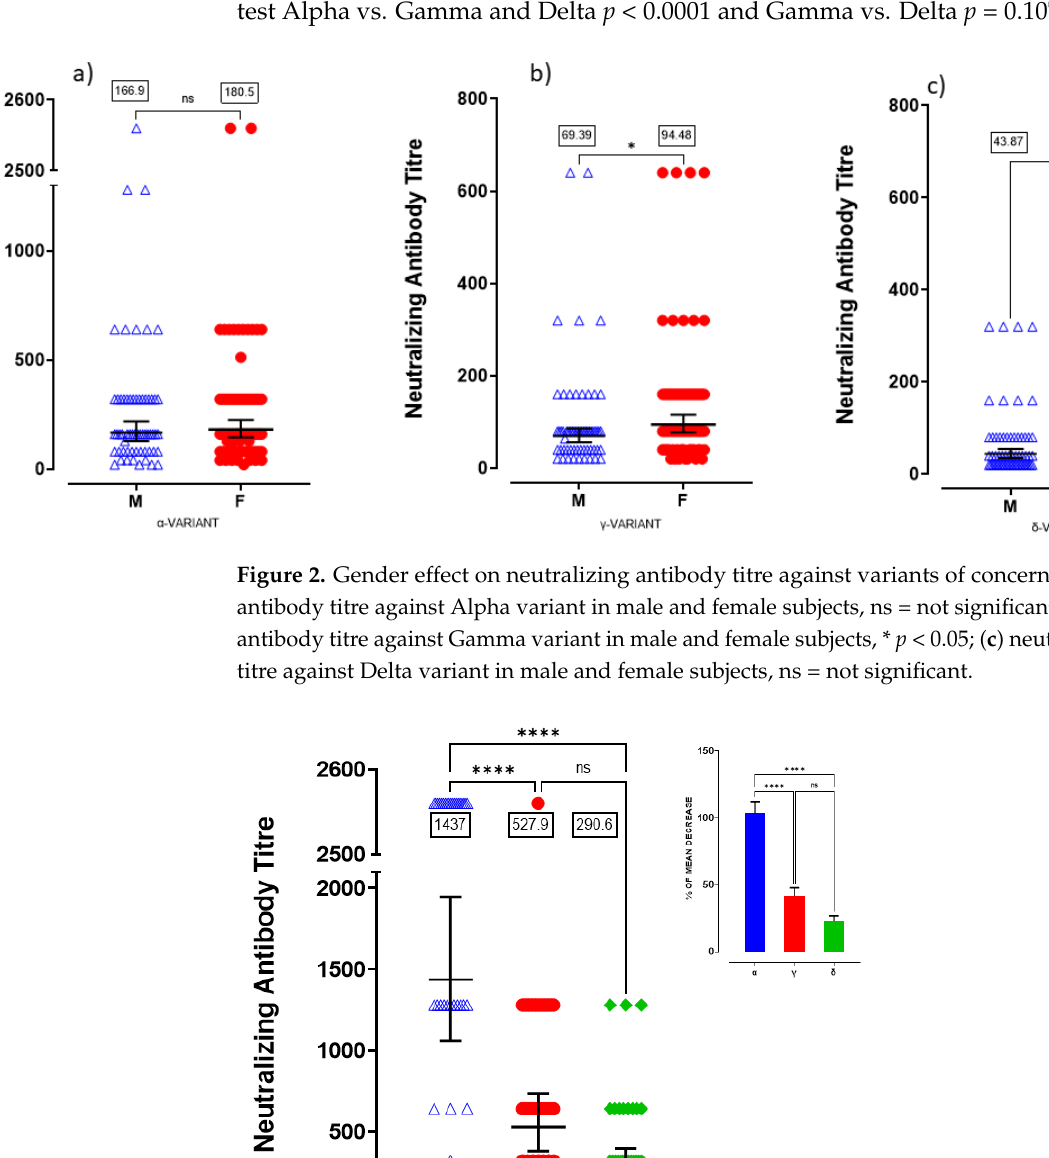
Figure 3. Neutralizing antibody titre against against variants of concern in COVID-19 recovered subjects. Neutralizing antibody titre against Alpha, Gamma and Delta variants in COVID-19 recov-